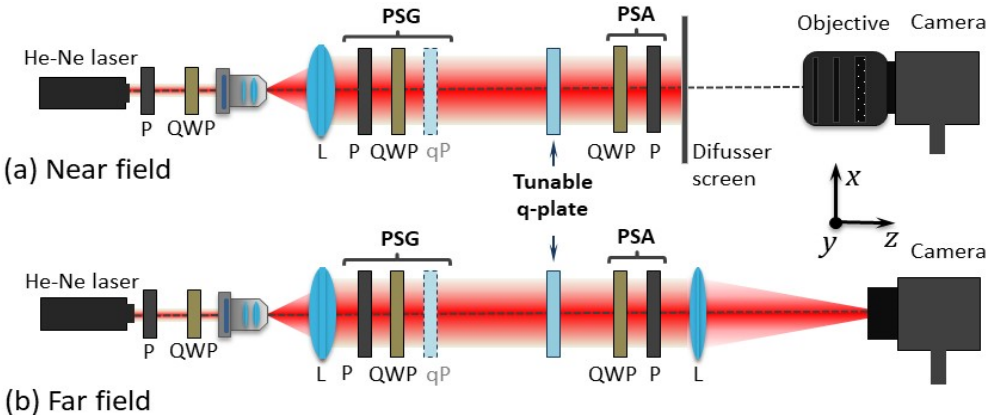
Figure 2. Optical setups for the generation of vector beams. ( a ) Setup to capture the near field. ( b ) Setup to capture the far field. P: linear polarizer; QWP: quarter-wave plate; qP: static q-plate; L: converging